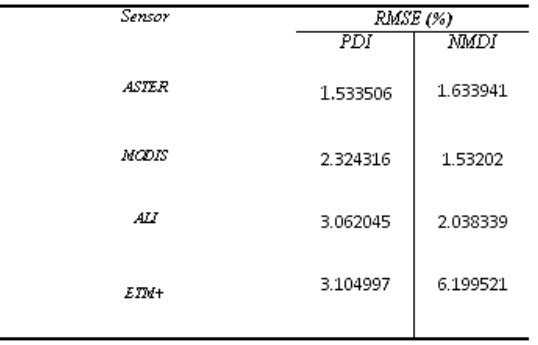
Table2. RMSE for evaluation of estimated NMDI and PDI for MODIS , ASTER , ALI, ETM + for soil moisture estimation